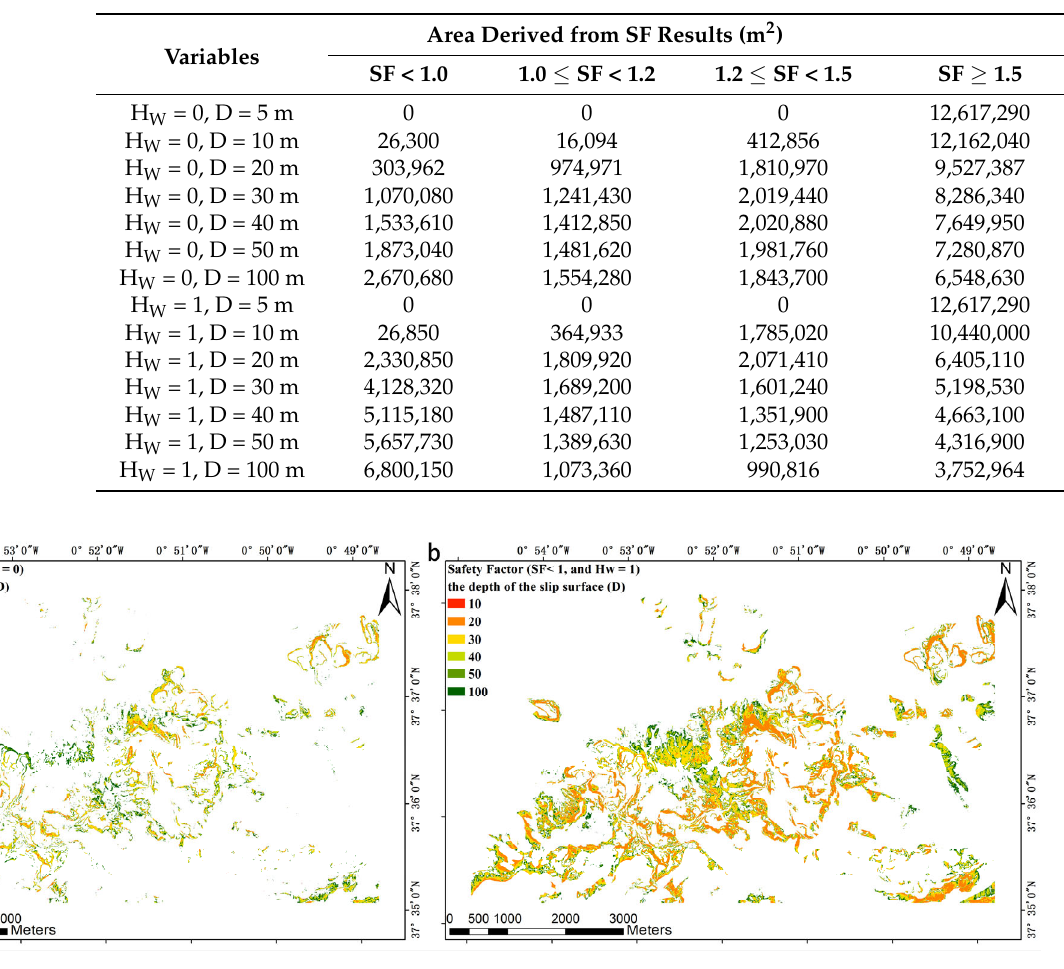
Table 3. Distribution of areas featuring an unstable (safety factor SF < 1.0), a poorly stable (1.0 ≤ SF < 1.2), a moderately stable (1.2 ≤ SF < 1.5), and a stable (SF ≥ 1.5) behavior for the two groundwater scenarios considered (H W equal either to 0 or 1) and for depth values of the slip surface (D) varying from 5 to 100 m.